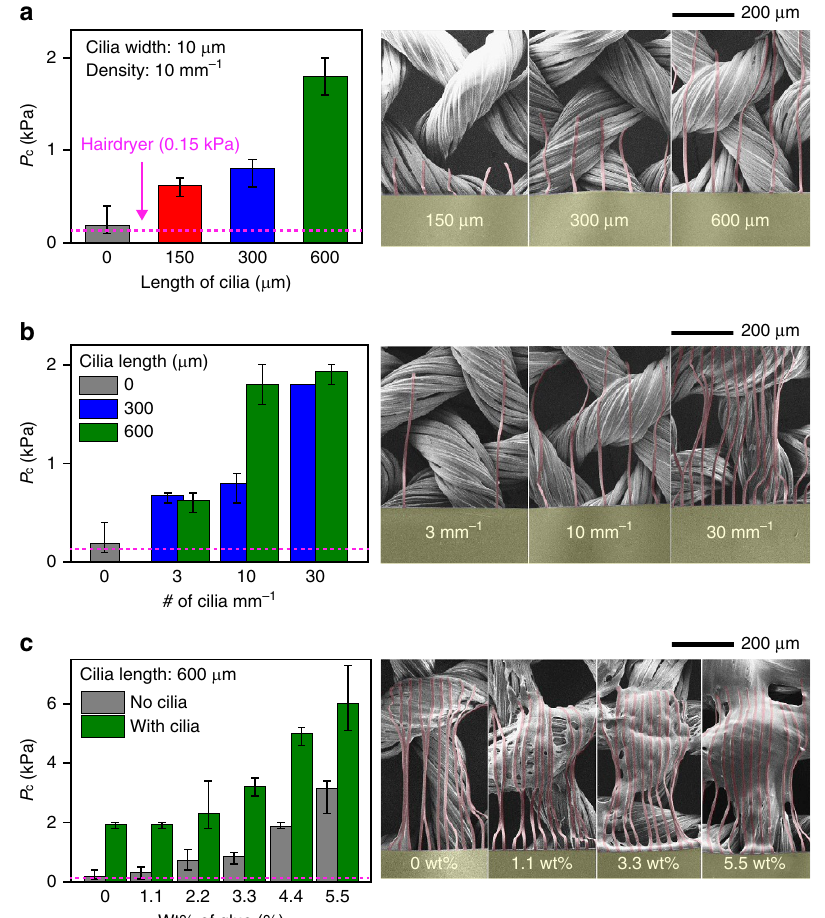
Figure 2 | Enhanced adhesion beneath ultrathin substrates by cilia and glue. ( a – c ) Blowing test for measuring critical pressure ( P c ) of the substrates with various cilia length scales ( a ), cilia densities ( b ) and concentrations of PDMS glue solution in toluene ( c ) for different six samples. The thickness and width of the cilia were set to 1.8 and 10 m m, respectively. The olive and red regions represent PI (thickness ¼ 2 m m)/Cr (70nm)/PI (2 m m) and PI (1.8 m m), respectively. The Cr interlayer was added for improving the optical contrast. The dashed lines at 0.15kPa, corresponding to the most intensive air blowing achievable using a conventional hairdryer, were added for